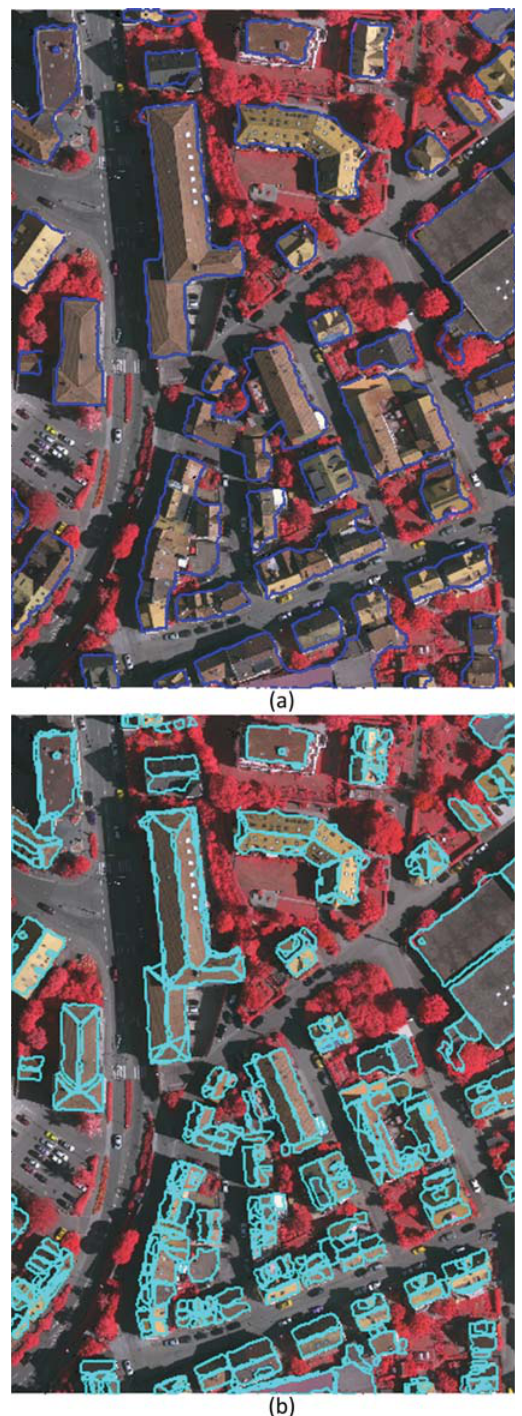
Figure 5: Building detection (a) and roof extraction results (b) on Area 1 of the VH data set.